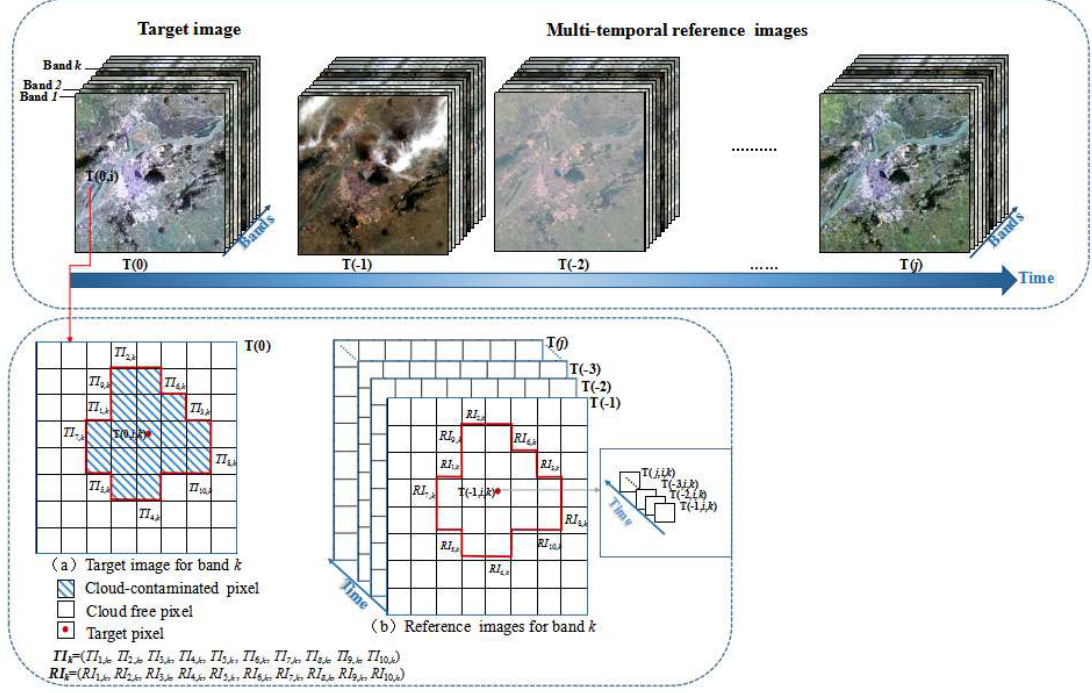
Figure 3. Schematic diagram of the cloud removal approach.